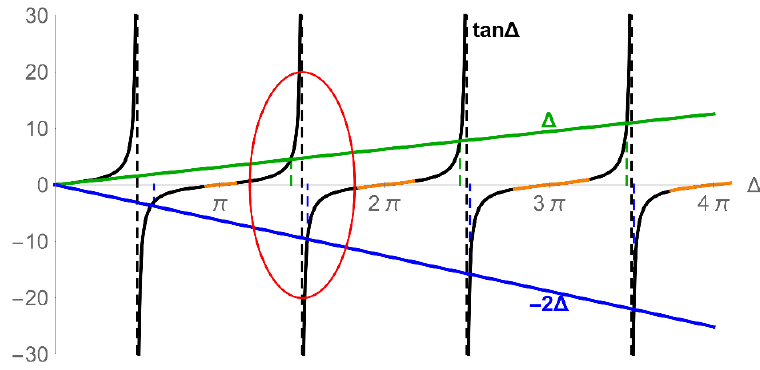
Figure 8 . Illustration of the position of the relevant zeros of A CPT , given by tan (cid:1) 31 = (cid:1) 31 , and (cid:22)e (cid:12) (cid:12) the maxima of (cid:12) A T (cid:22)e (cid:12) , given by tan (cid:1) 31 = (cid:0) 2(cid:1) 31 . The vertical dashed lines are the asymptotes of tan (cid:1) (black), corresponding to oscillation maxima, and the perturbative solutions of the previous (cid:2) (cid:3) (cid:0) 1 (cid:2) (cid:3) (cid:0) 1 equations, (cid:1) CPT = (2 n + 1) (cid:25) (cid:0) (2 n + 1) (cid:25) (green) and (cid:1) T = (2 n + 1) (cid:25) + 1 (2 n + 1) (cid:25) max 0 2 2 2 2 2 (blue). As calculated in eq. (6.5), the (cid:14) -dependent zeros of A CPT around (cid:1) 0 = n(cid:25) are bounded (cid:22)e within the orange regions of tan (cid:1). The highest-energy point, i.e. smallest (cid:1), where A CPT vanishes (cid:22)e (cid:14) -independently is emphasized by the red